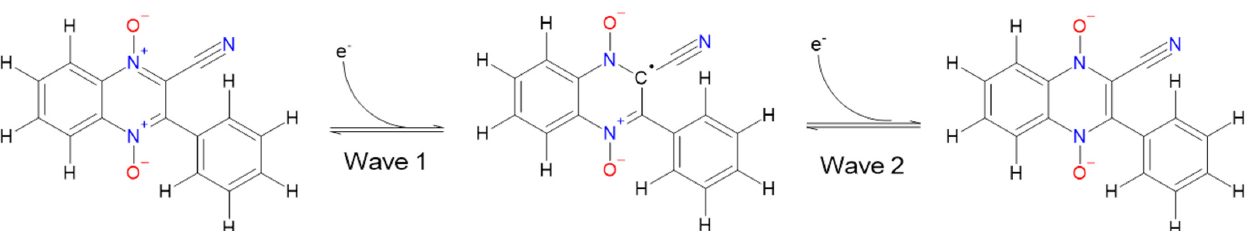
Figure 1. The first reduction (wave 1) and second reduction (wave 2) of the diazine ring in the parent 3-phenyl-quinoxaline-2-carbonitrile 1,4-di-N-oxide, derivative A1. Chemical structures were drawn in ChemSketch FreeWare [19].